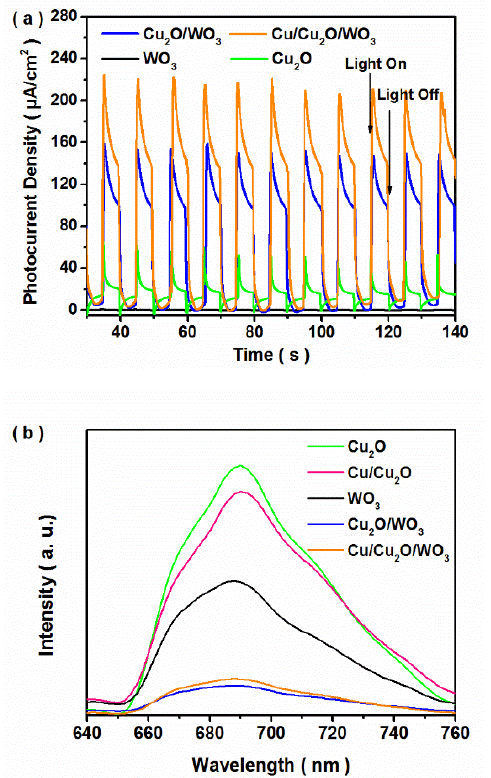
Figure 7. Photocurrent density ( a ) and photoluminescence spectra ( b ) of the obtained samples.